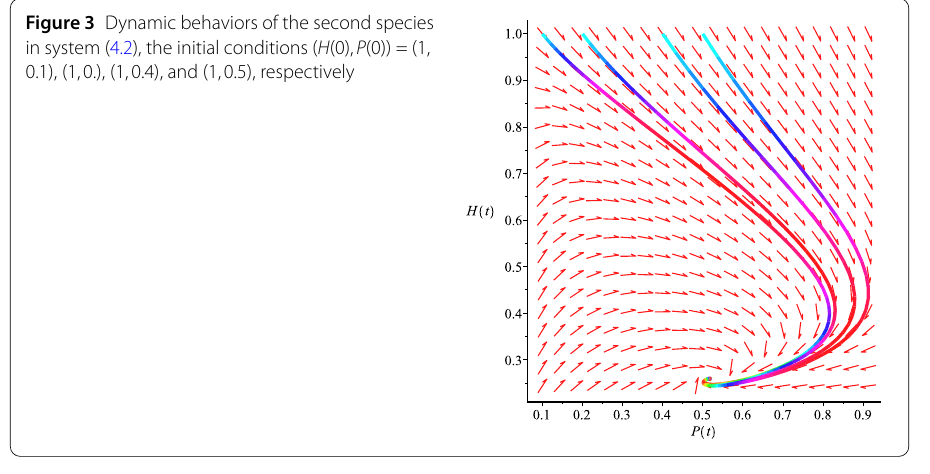
Figure 3 Dynamic behaviors of the second species in system (4.2), the initial conditions ( H (0), P (0)) = (1, 0.1), (1,0.), (1,0.4), and (1,0.5),